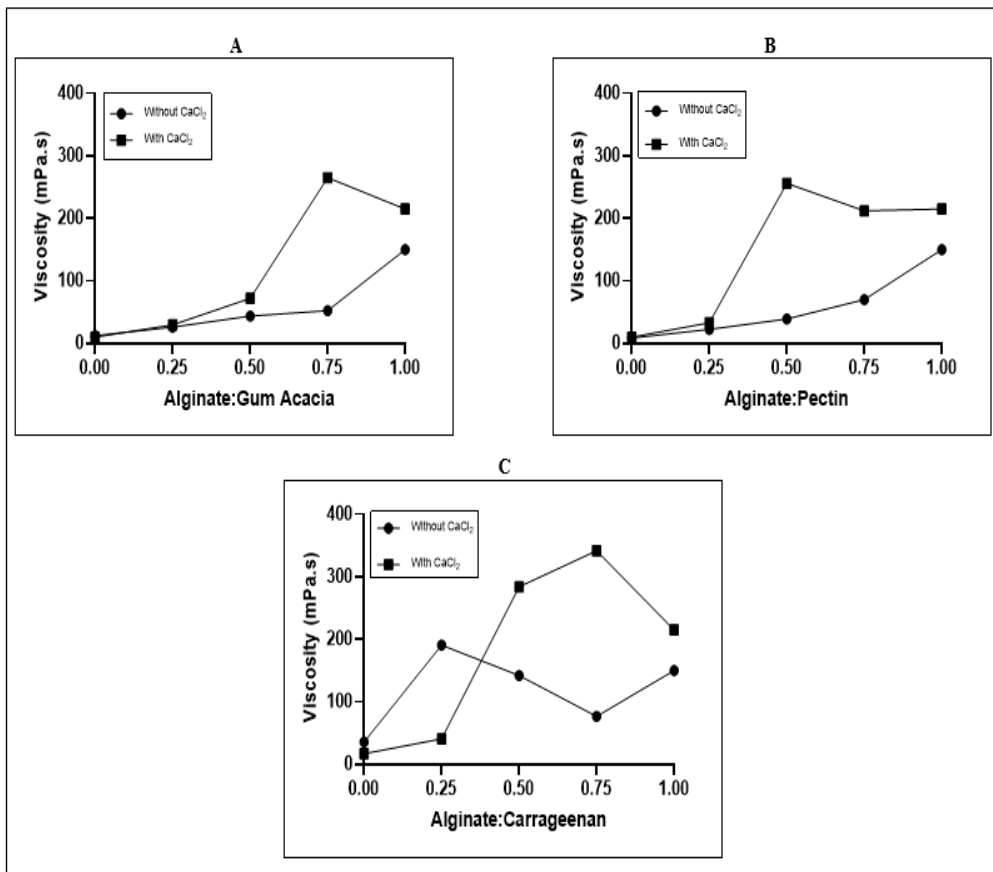
Figure 1. The viscosity of mixture solution polymer with presence and absence CaCl 2 . (a) alginate with gum acacia; (b) alginate with pectin; and (c) alginate with carrageenan. data shown are the average values and standard deviation (n=3).